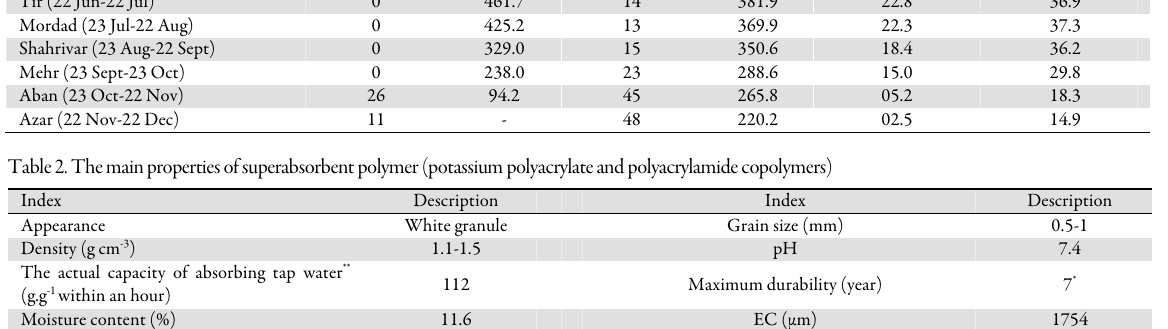
Table 1. The main climatic indices during the experiment Growth months (Local months and their A.D equivalents )